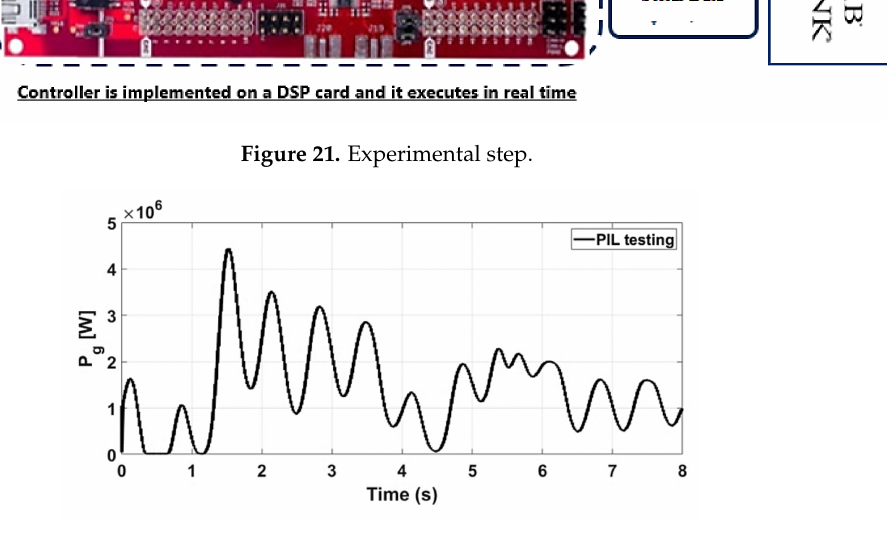
Figure 22. Active power.